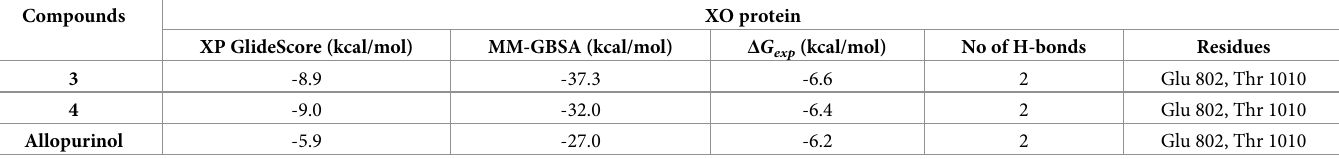
Table 2. The XP docking and MM-GBSA values of two filtered compounds (3 and 4) and allopurinol. Compounds